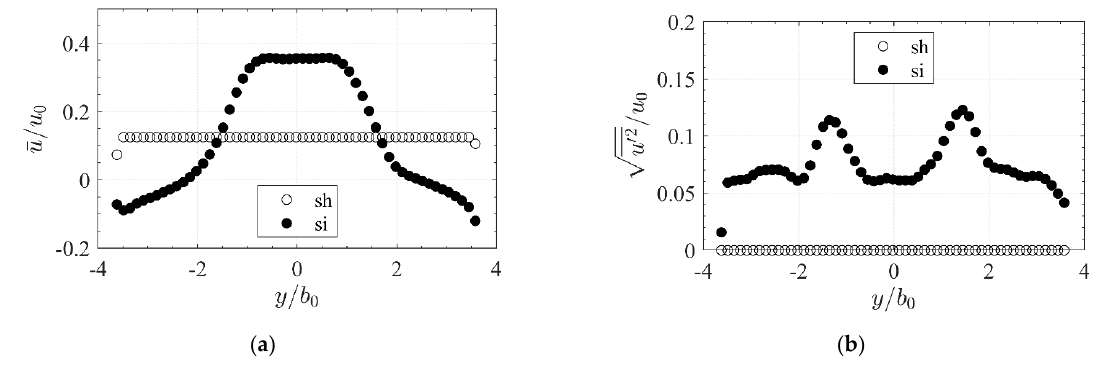
(cid:113) u (cid:48) 2 / u 0 in